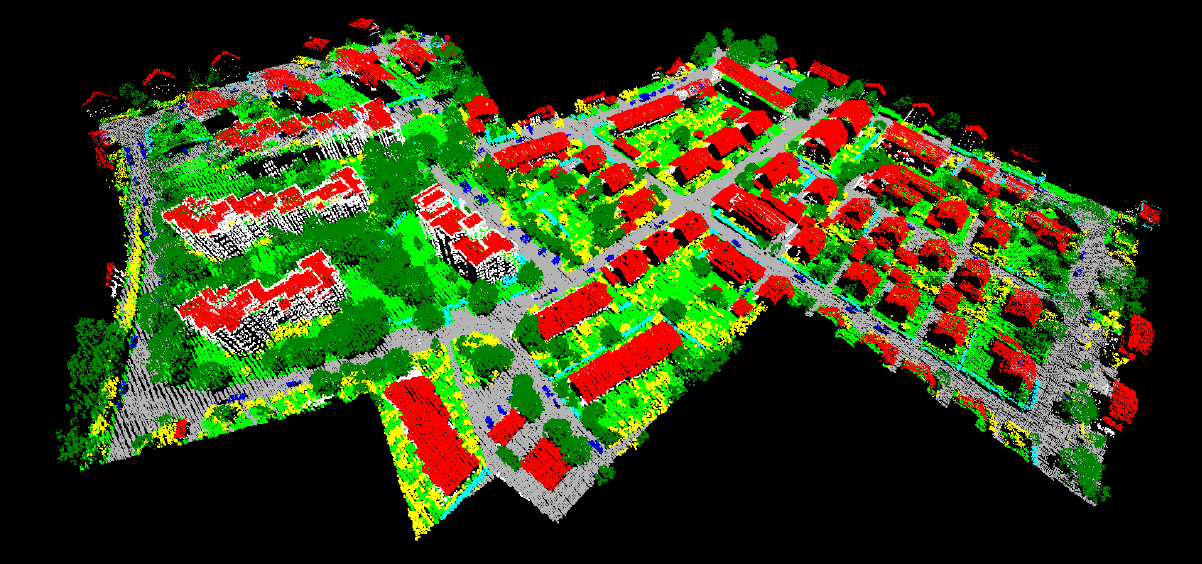
Figure 1. Point cloud colored with respect to nine semantic classes ( Roof : red; Fac¸ade : white; Impervious Surfaces : gray; Car : blue; Tree : dark green; Low Vegetation : bright green; Shrub : yellow; Fence / Hedge : cyan; Powerline :